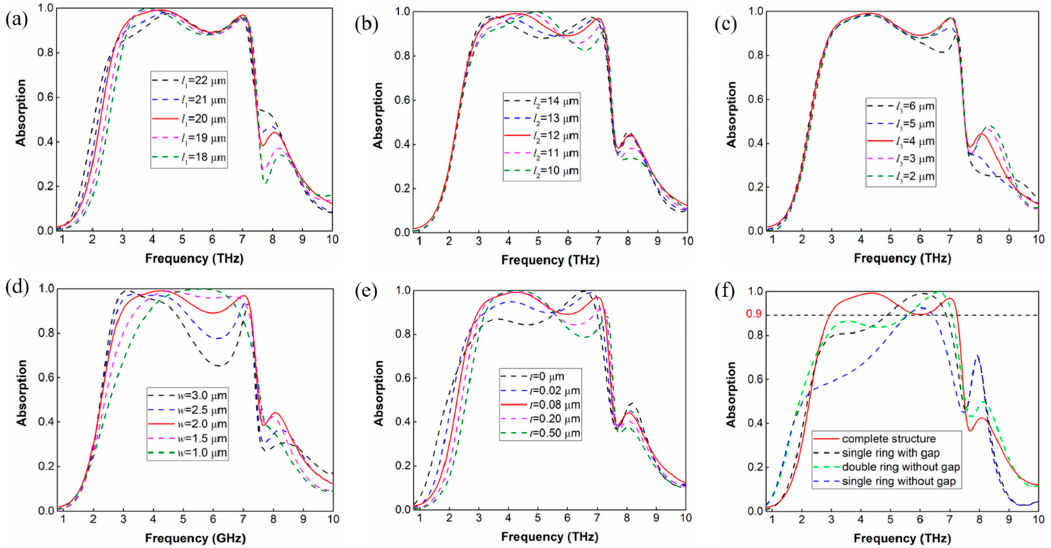
Figure 8. Absorption spectrum of different geometric parameters such as ( a ) the length of outer ring l 1 , ( b ) the length of middle ring l 2 , ( c ) the length of inter block l 3 , ( d ) the width of rings w , ( e ) the gap width t on the rings, and ( f ) four different structures.